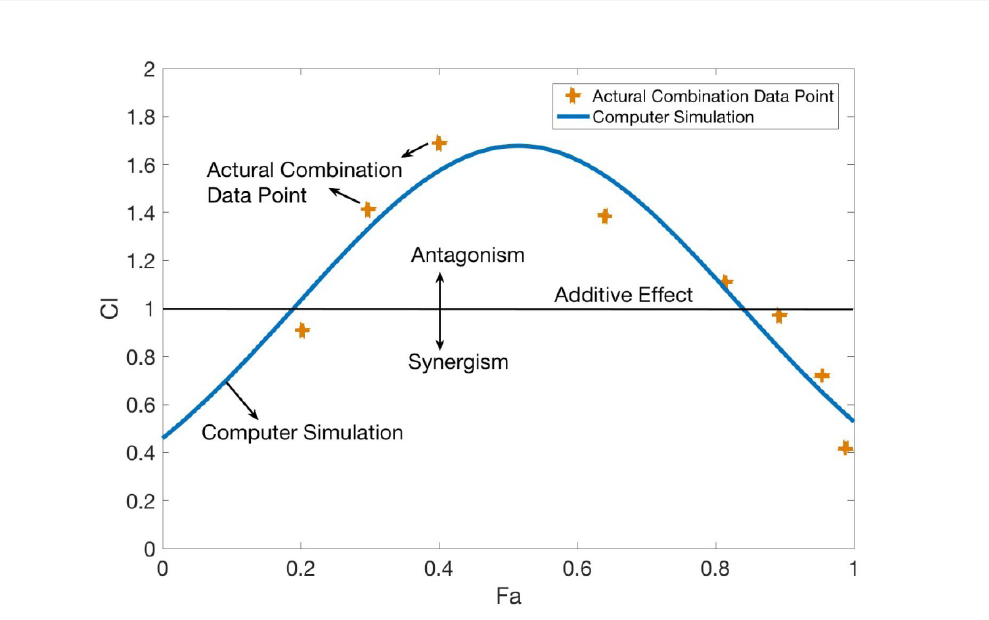
FIGURE 4 - The Fa-CI plot when the ratio of SAA and HSYA is 1:1.